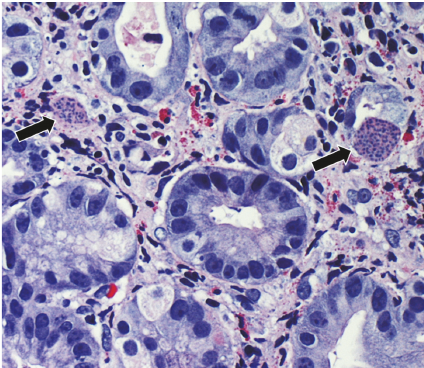
Figure 4: Gastric biopsy specimen showing large cystic forms present in the glandular epithelium and stroma within a background of eosinophils. The arrows refer to toxoplasmosis cyst present within the gastric biopsy.